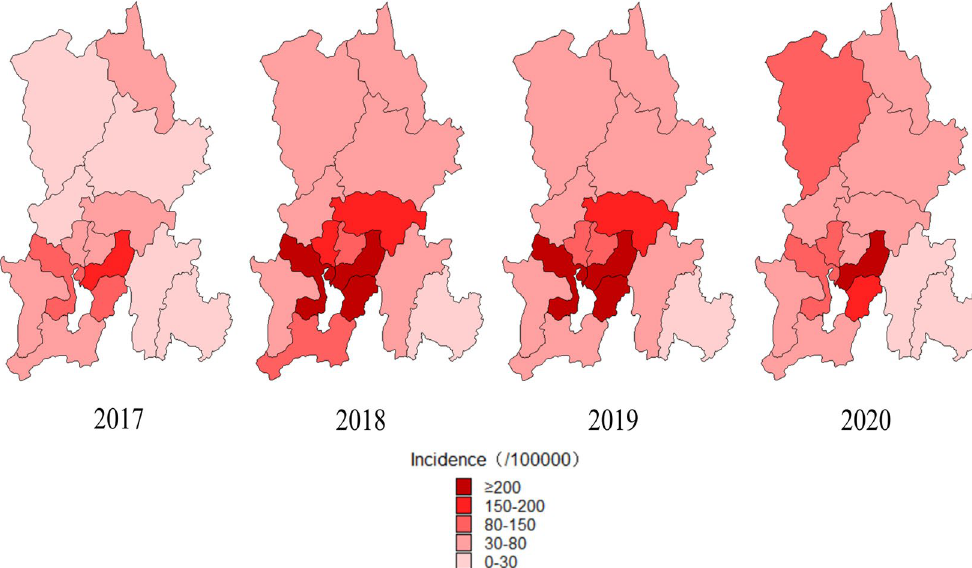
Figure 3. The spatial distribution map of HFMD annual incidence of districts and counties in Kunming, 2017– 2020. The number of HFMD cases mainly concentrated in Guandu, Xishan, Wuhua, Panlong and Chenggong, and the high incidence of HFMD areas were Guandu, Chenggong and Xishan. This figure was drawn by MapInfo 10.0 spatial distribution software [url = http:// www.i- mapin fo. com]MapInfo[/url].